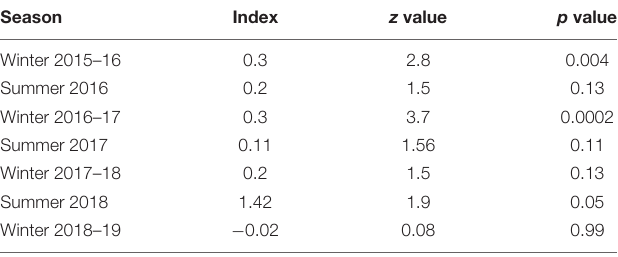
TABLE 4 | Spatial autocorrelation (Moran’s I ) test was used to examine whether camera-trap sites were independent across seven sampling sessions, 2015–2019, in the Nelang valley of the Gangotri National Park, Uttarakhand, India.